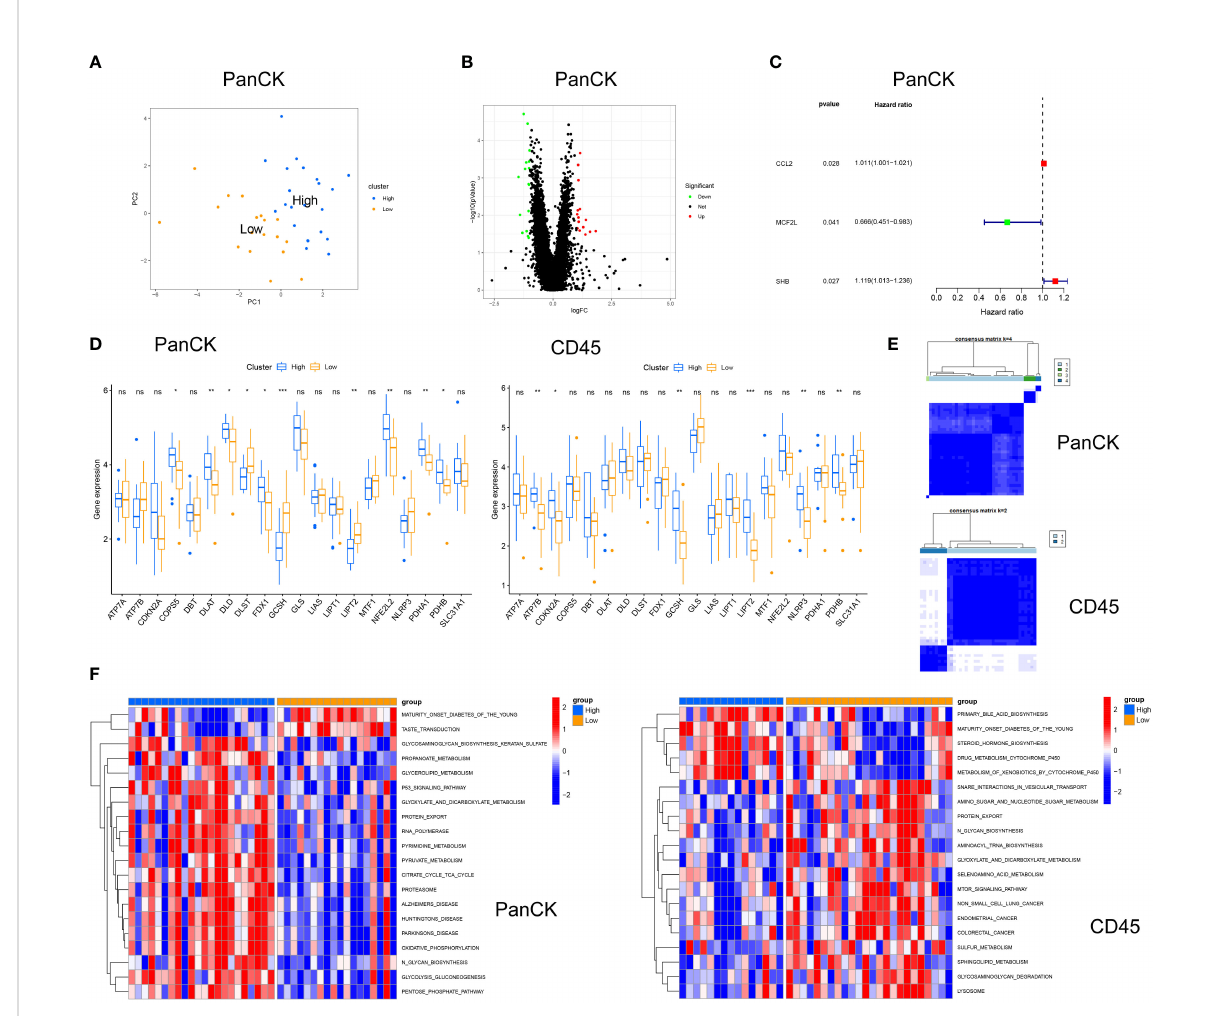
FIGURE 5 Cuproptosis related genes for strati fi cation in tumor cell-enriched region and immune cell-enriched regions. (A) Principal Component Analysis in tumor cell-enriched region. (B) Differential analysis in Tumor cell-enriched region, green for downregulation, red for upregulation, log|FC|>1 and P<0.05. (C) Univariate Cox analysis in tumor cell-enriched region. (D) Differential expression of cuproptosis related genes and Jab1 between high and low score groups. (E) Typing in Tumor cell-enriched region: four clusters. Typing in immune cell-enriched region: two clusters (F) GSVA for high and low score groups in tumor cell-enriched regions and immune cell-enriched regions. *p<0.05, **p<0.01, ***p<0.001, ns, not signi fi